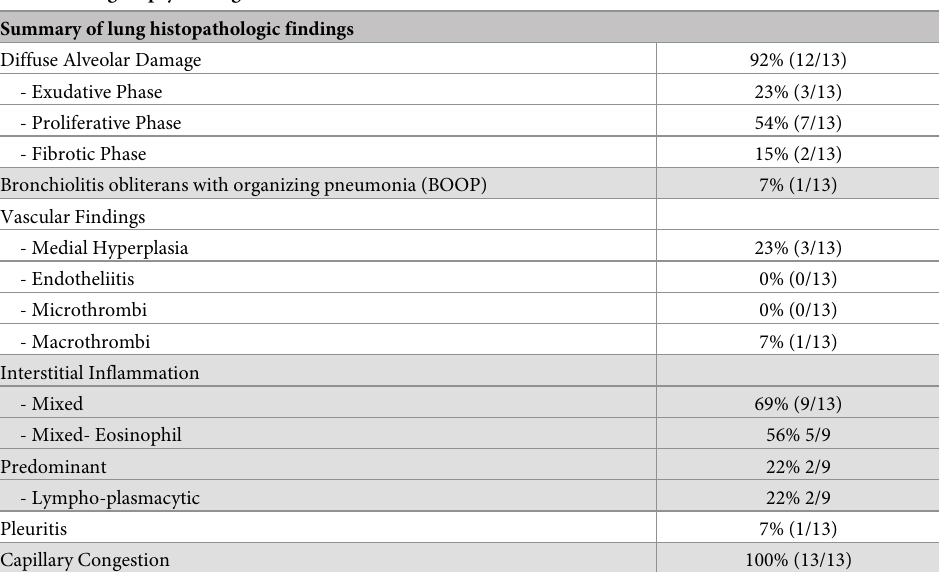
Table 3. Lung biopsy findings. Summary of lung histopathologic